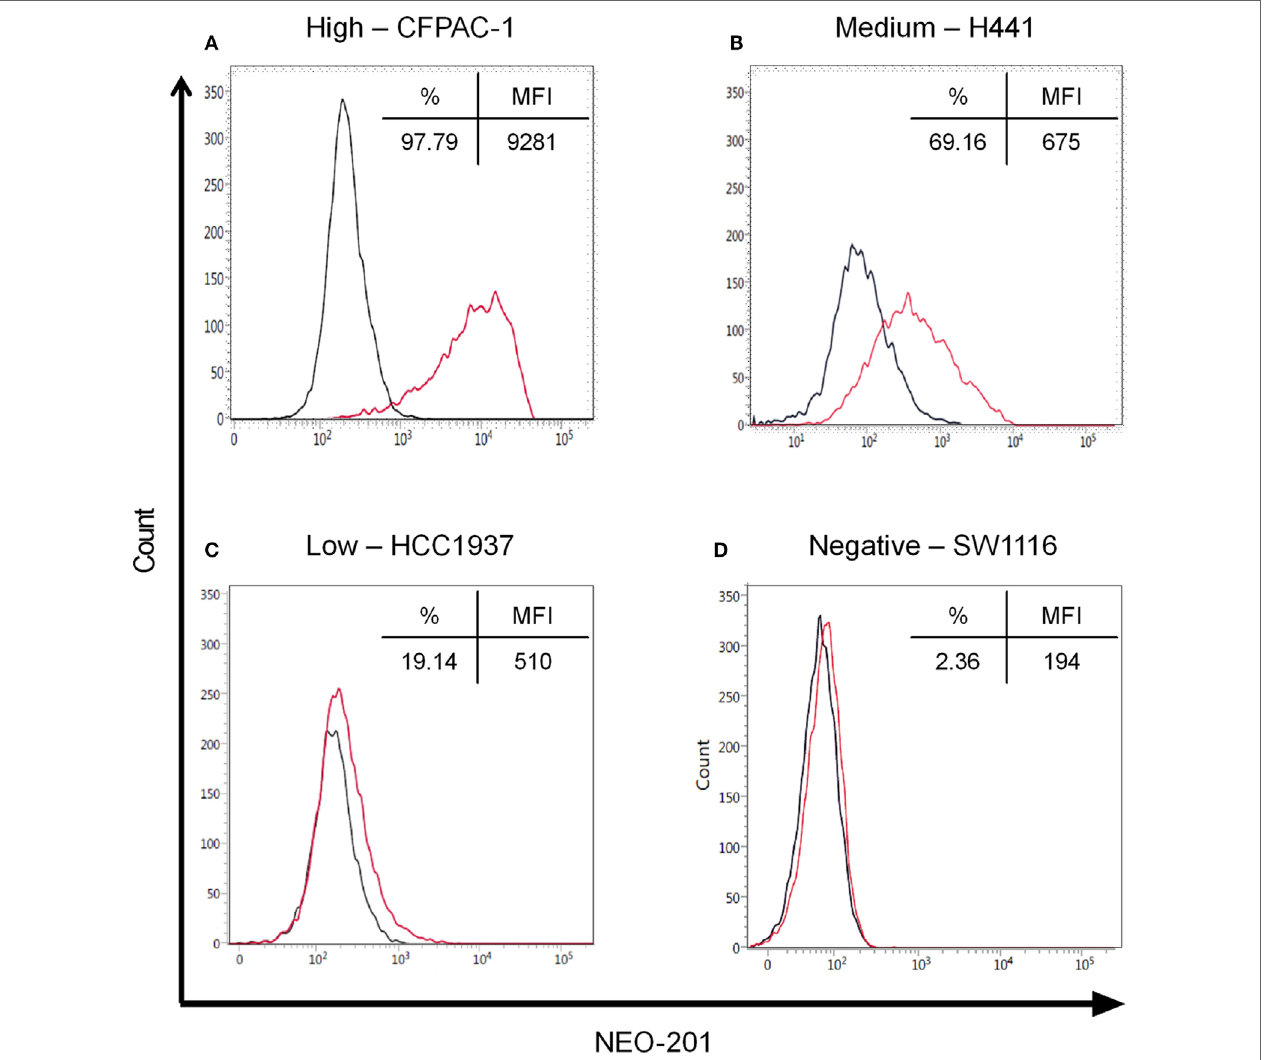
FigUre 1 | Flow cytometry of NEO-201 binding to human carcinoma cell lines. Representative human carcinoma cell lines with various levels of NEO-201 antigen expression, (a) pancreatic CFPAC-1 (high), (B) non-small cell lung carcinoma H441 (medium), (c) breast HCC1937 (low), and (D) colon SW1116 (negative). Results are expressed as % NEO-201 positive and median fluorescence intensity (MFI) for each cell line. Red, NEO-201-stained cells; black, unstained cells. NEO-201 positivity was defined as % positive ≥